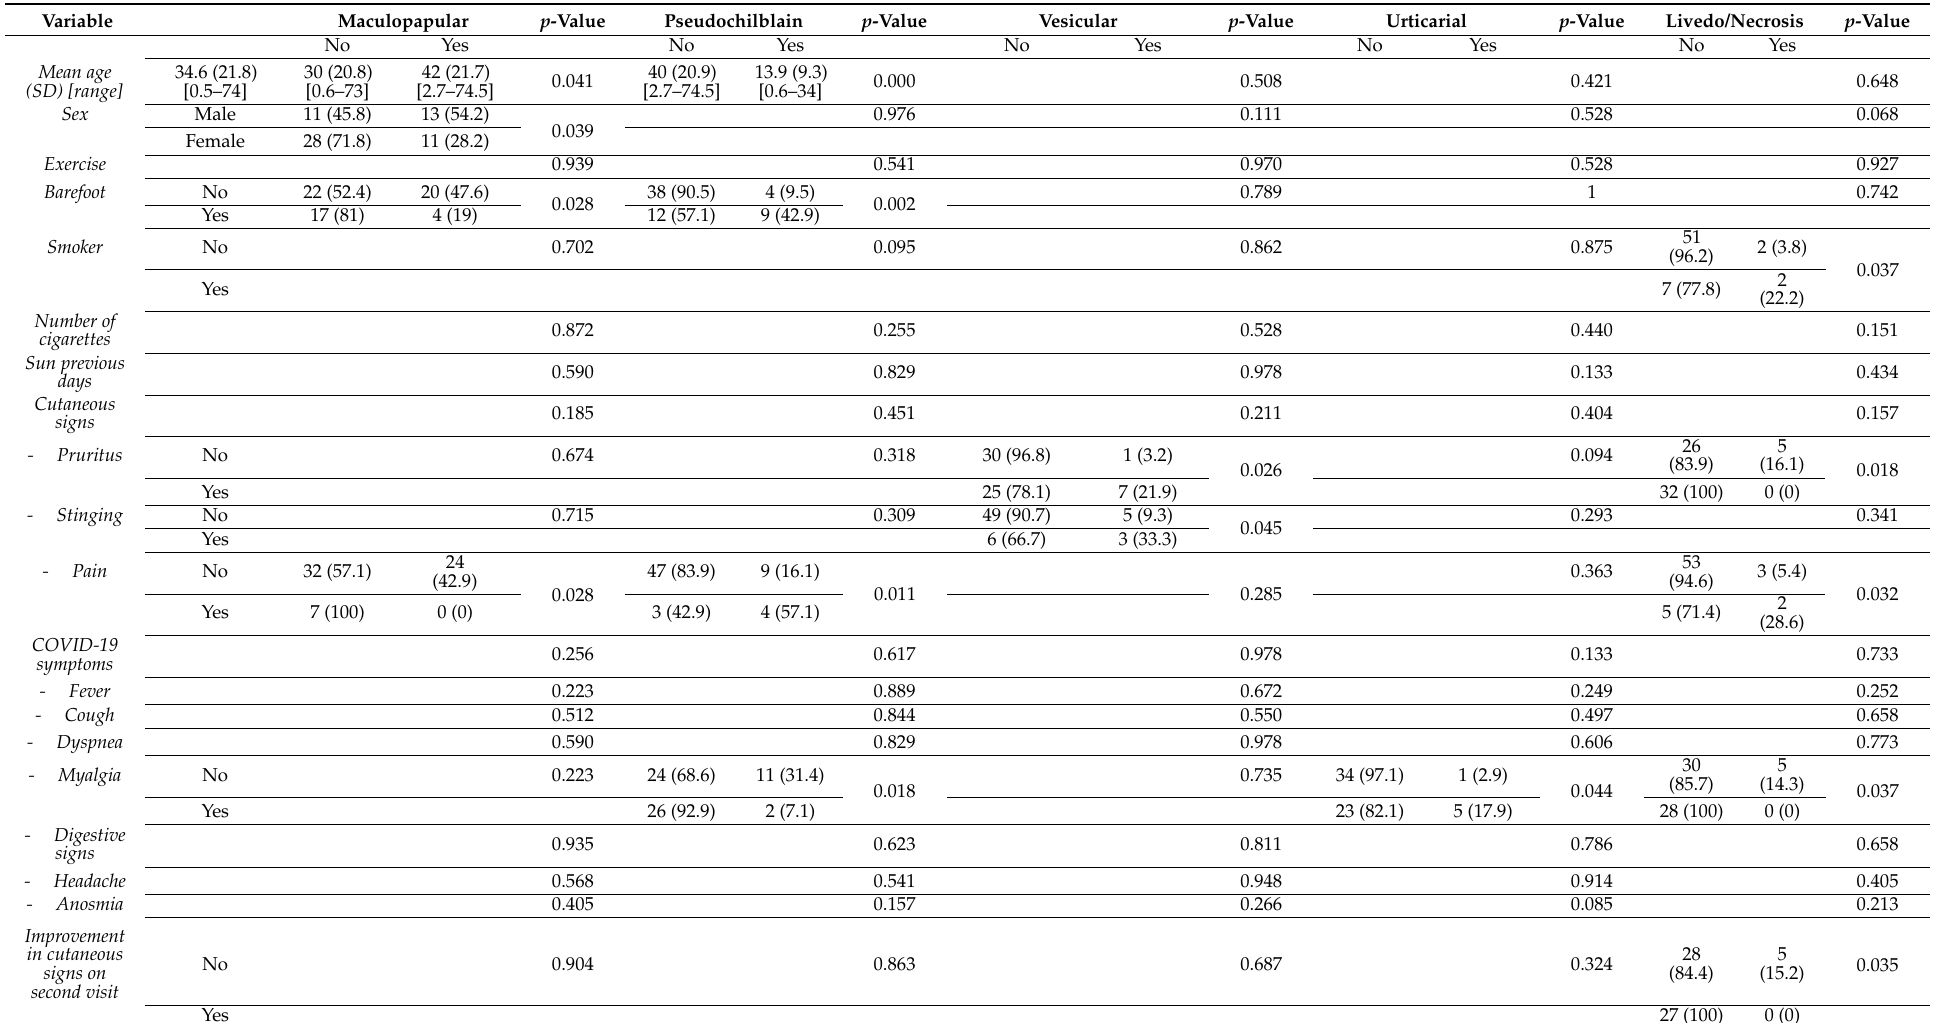
Table 4. Bivariable analysis performed to identify variables associated with any of the different cutaneous